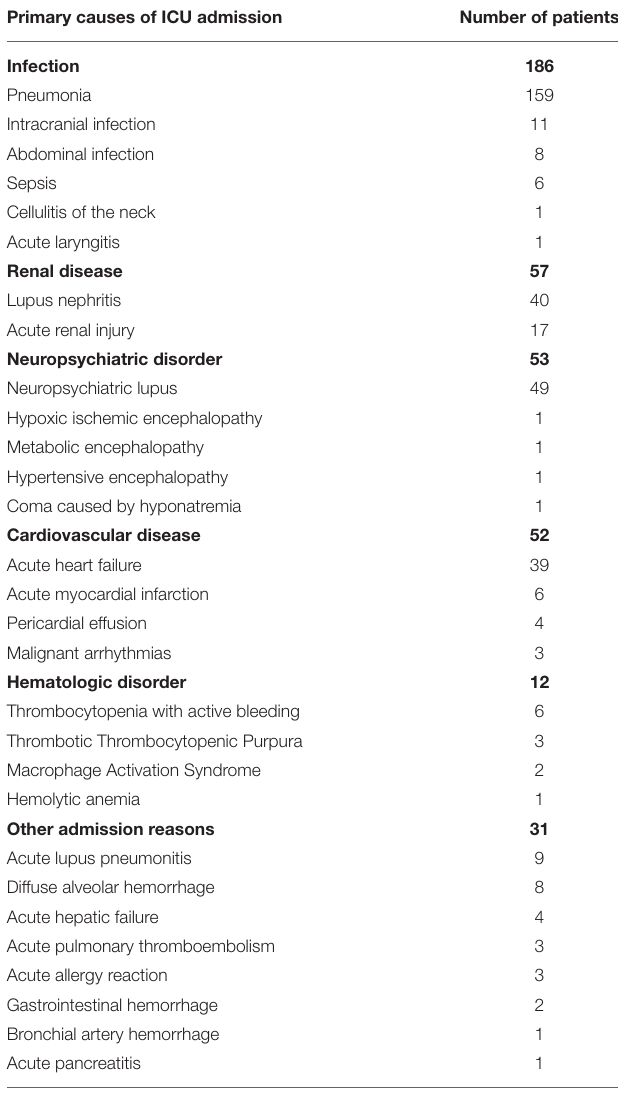
TABLE 2 | Primary causes of ICU admission of the 391